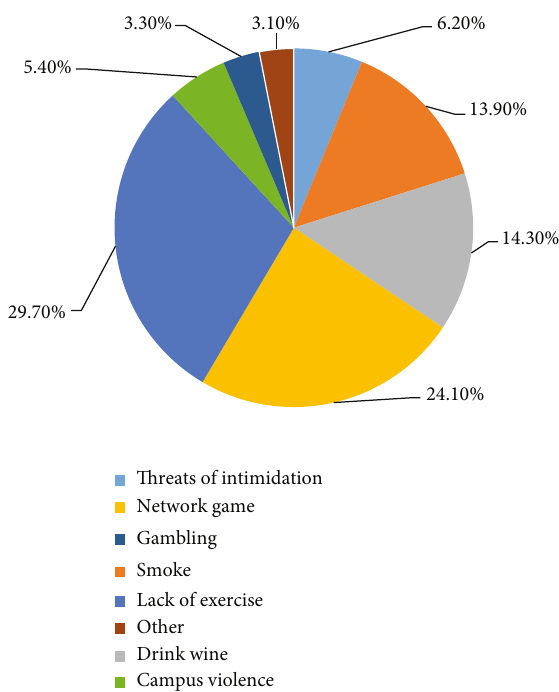
Figure 1: Investigation on adverse phenomena of